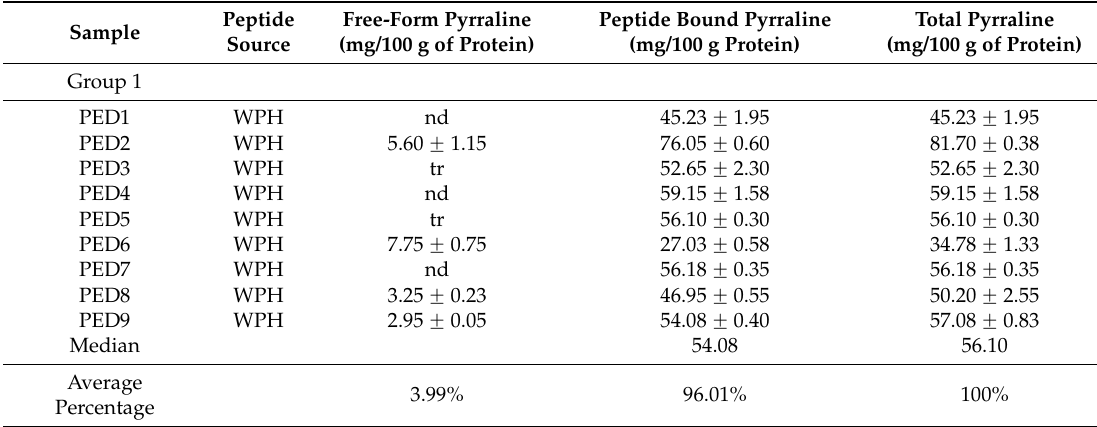
Table 2. Concentrations of free-form and peptide bound pyrraline in 27 commercial PEDs.